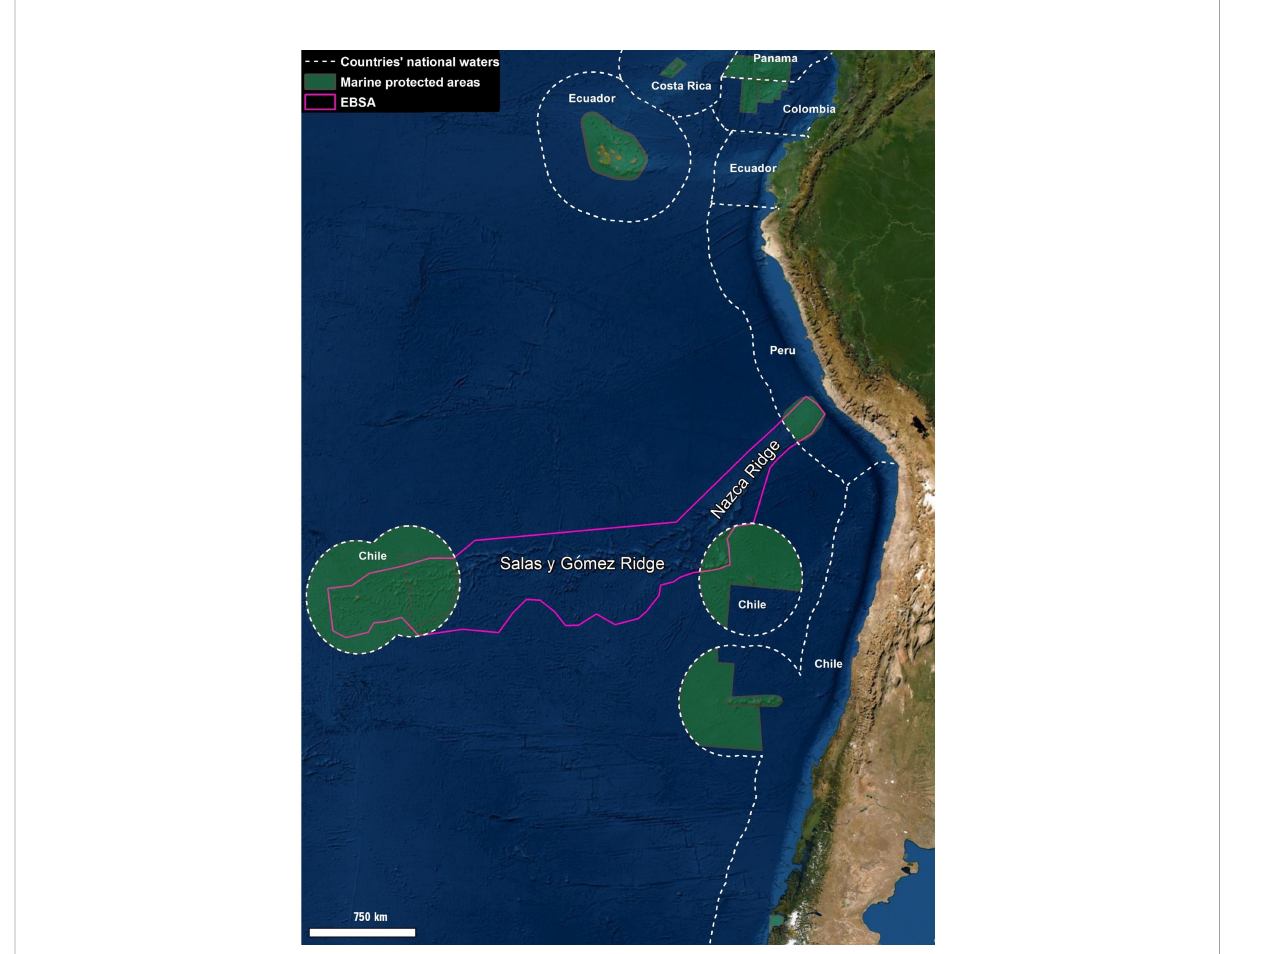
FIGURE 1 Map showing the location of MPAs around the Salas y Go ́ mez and Nazca ridges. Over 73% of Salas y Go ́ mez and Nazca ridges lie in ABNJ where they are